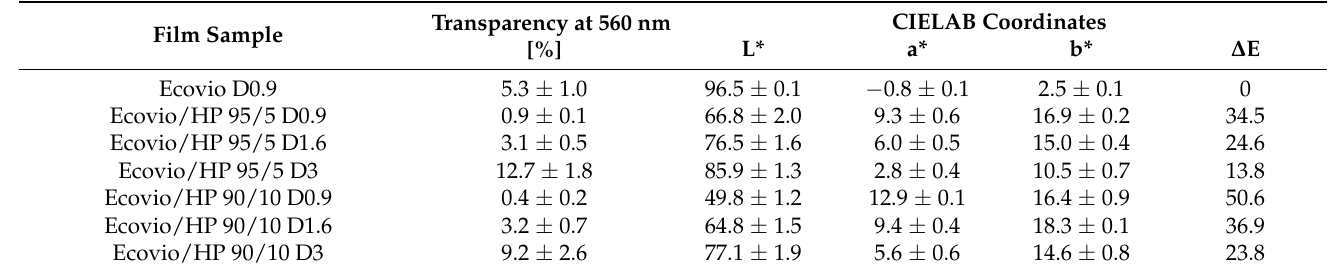
Table 9. Transparency and CIELAB color variables of films with different average thickness and hazelnut perisperm